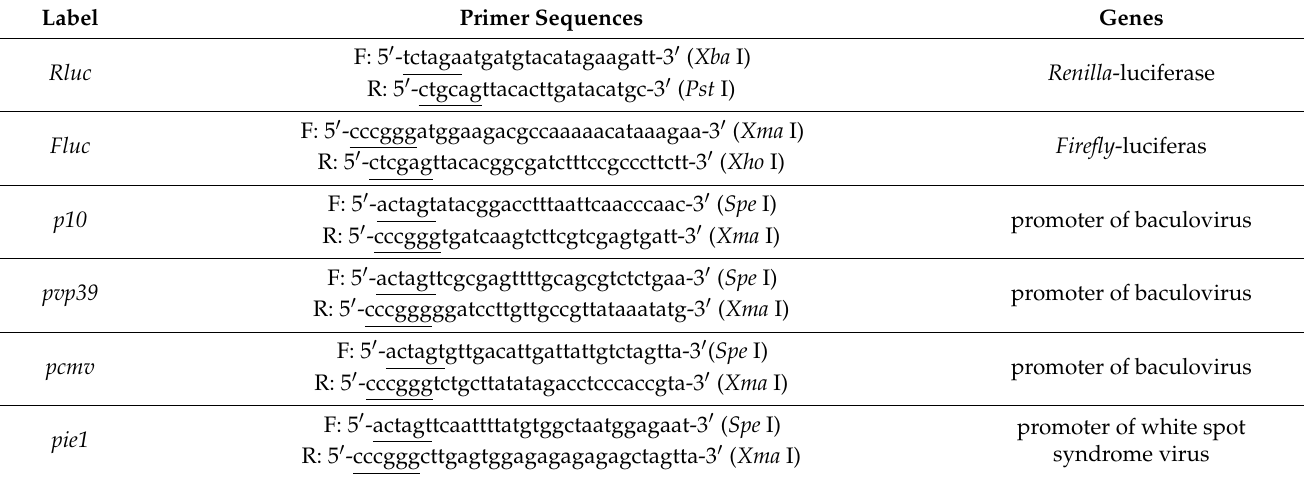
Table 1. Primers used to amplify the target gene.